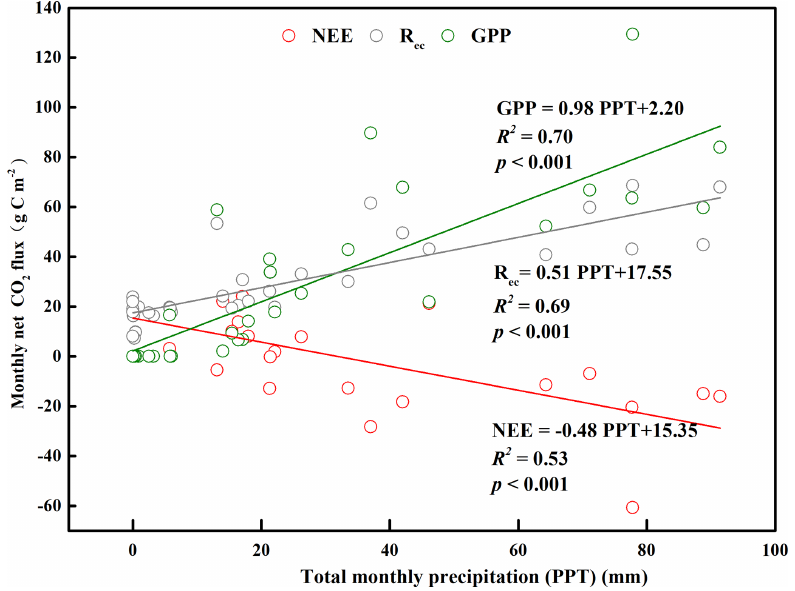
Figure 6. Relationship between total monthly precipitation (PPT) and monthly net ecosystem carbon exchange (NEE), gross primary pro- ductivity (GPP), and ecosystem respiration ( R ec ) for the years with a complete dataset (2015, 2016, and 2018).